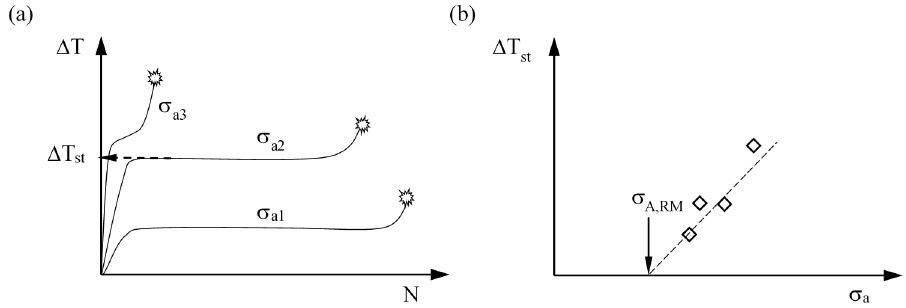
Figure 2. Material temperature evolution during a constant amplitude fatigue test ( a ); material fatigue limit evaluation according to the Risitano method [5] ( b ).